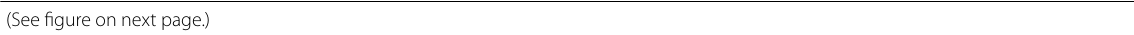
figure on next Fig. 2 Cultivation of C. cellulovorans with SBP and Avicel. a Total sugar concentration after 11-days cultivation in the culture with SBP (left) and Avicel (right), where negative control (open bar), C. cellulovorans (closed bar) are included. b Cell growth in the culture with SBP (left) and Avicel (right). c Organic acid concentration in the culture with SBP (left) and Avicel (right), where lactic acid (Δ), acetic acid (*), butyric acid (black filled circle) are included. d Reduced sugar concentration in the culture with SBP (left) and Avicel (right). e Gas production after 11-days cultivation in the culture with SBP (left) and Avicel (right), where H 2 (closed bar), CH 4 (hatched bar), CO 2 (open bar) are included. Values indicate increments from the volume of negative control and are calculated as the volume per one kg of dry weight of substrates. Values with error bars are mean independent samples. An asterisk indicates a significant difference (p <